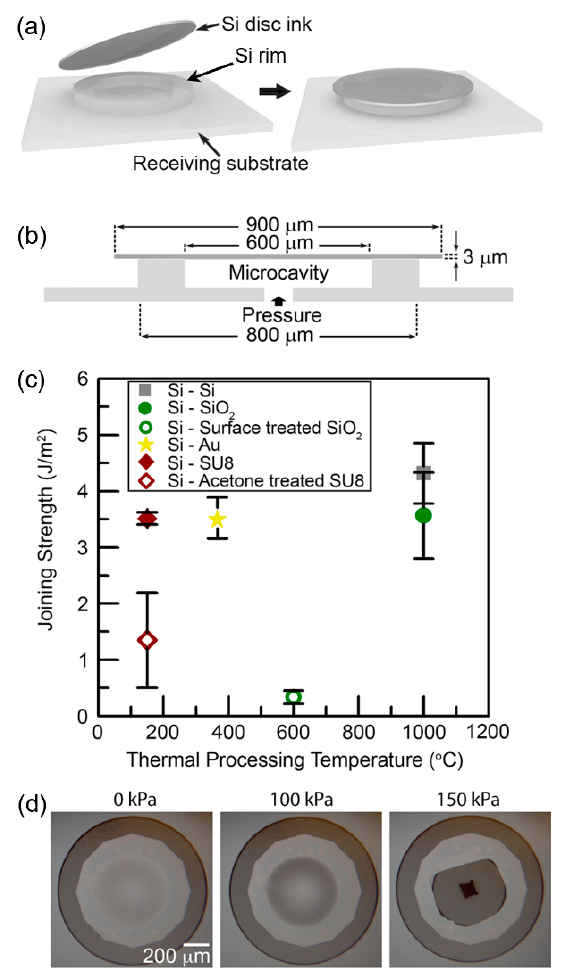
Figure 7. A blister test specimen and results of measured joining strength. ( a ) Schematics of an Si–Si